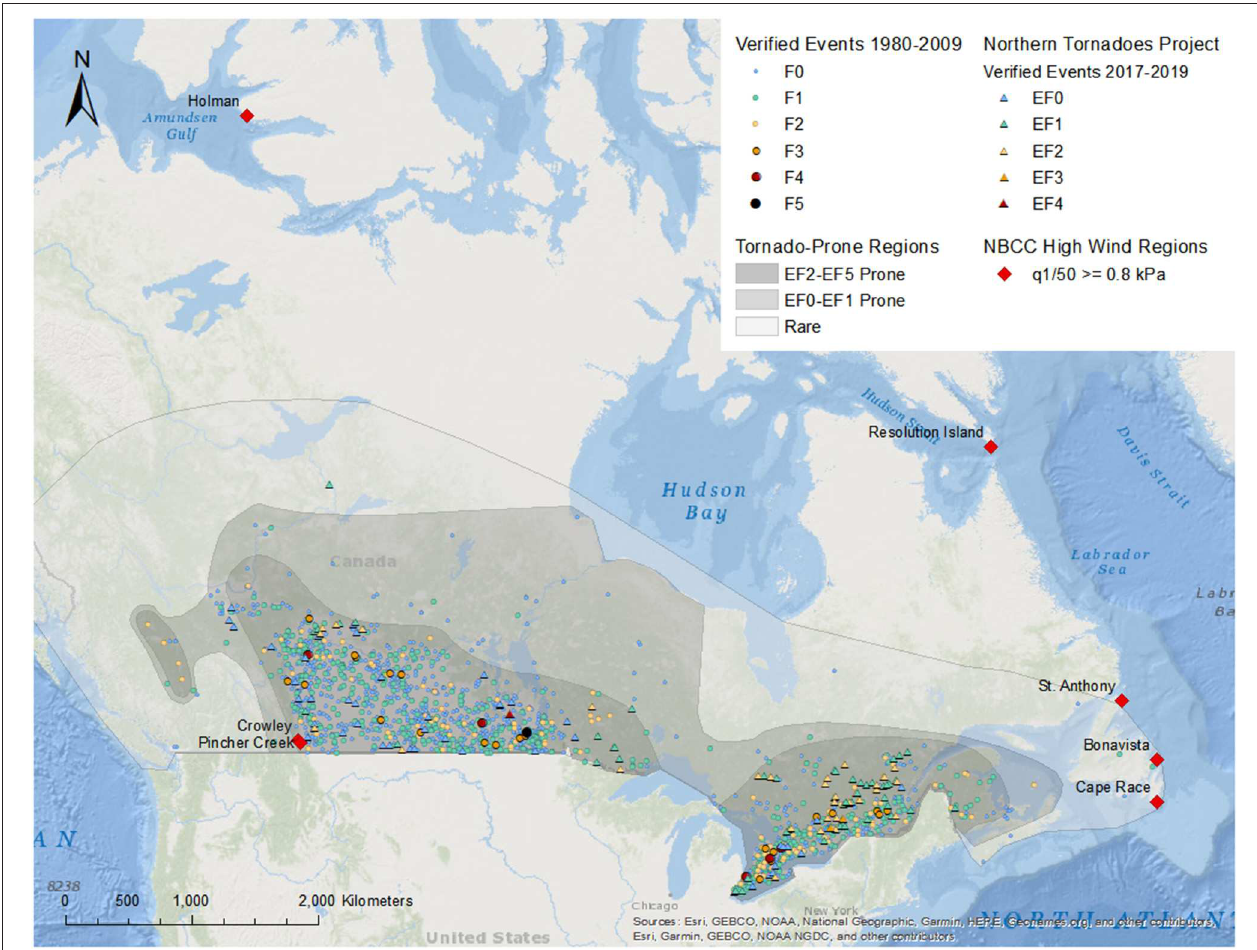
FIGURE 1 | Map showing historical tornado record (Environment Canada, 2018), recent confirmed events (Northern Tornadoes Project, 2020), tornado-prone regions as defined by Sills et al. (2012), and locations considered by the NBCC (Canadian Commission on Building and Fire Codes, 2015) to face high wind